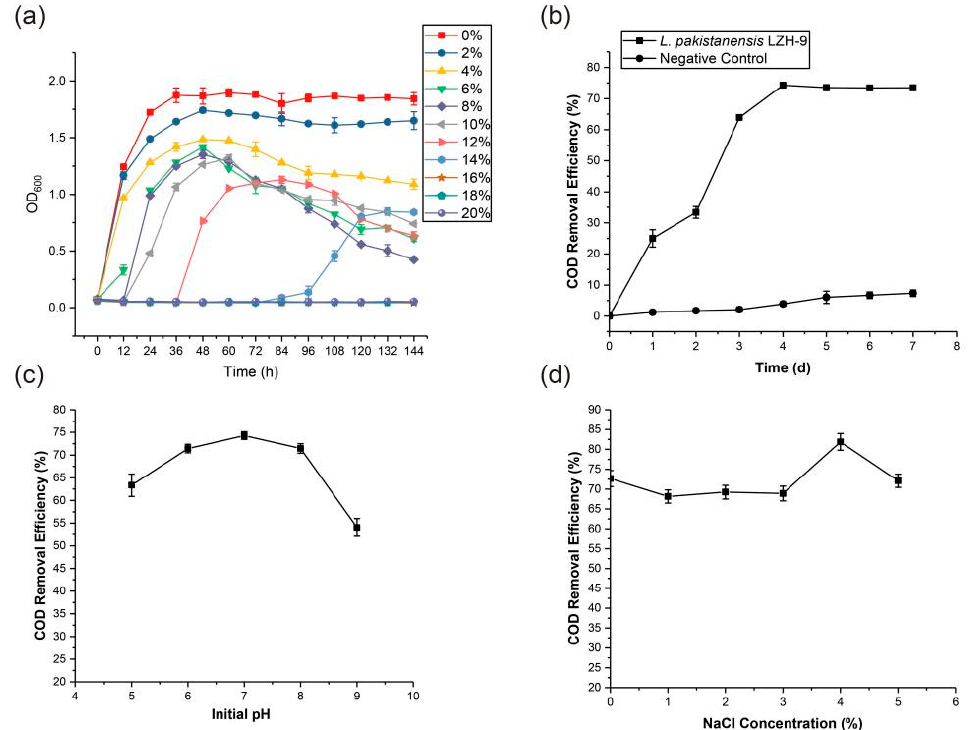
Figure 3. ( a ) Growth curves of strain Lysinibacillus pakistanensis LZH-9 under different NaCl concentrations, tested in triplicate. ( b ) Effects of incubation time on the COD removal efficiency percentage in synthetic wastewater. The initial concentration of NaCl was 1%, inoculum concentration was 5% and strain LZH-9 was cultured with an initial pH 7.0. ( c ) Effects of initial pH on the COD removal efficiency percentage in synthetic wastewater. The effect of initial pH was tested at the 4th day. The initial concentration of NaCl was 1%. ( d ) The effects of initial NaCl concentration on the COD removal efficiency in synthetic wastewater. The effect of initial NaCl concentration was tested at the 96 h.